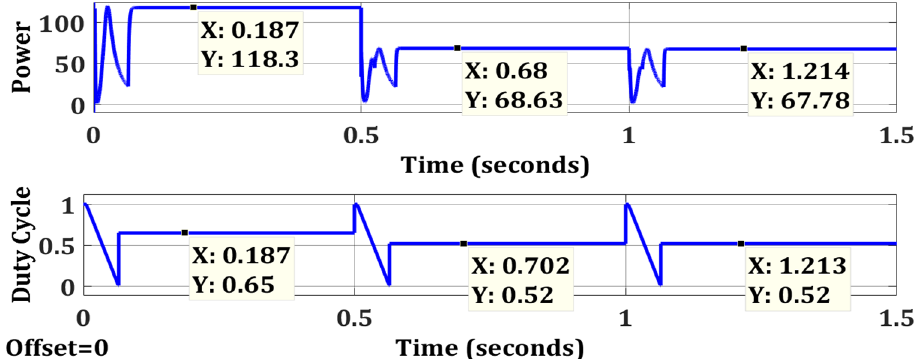
Figure 41. Changing weather conditions for 2S2P PV system configuration .